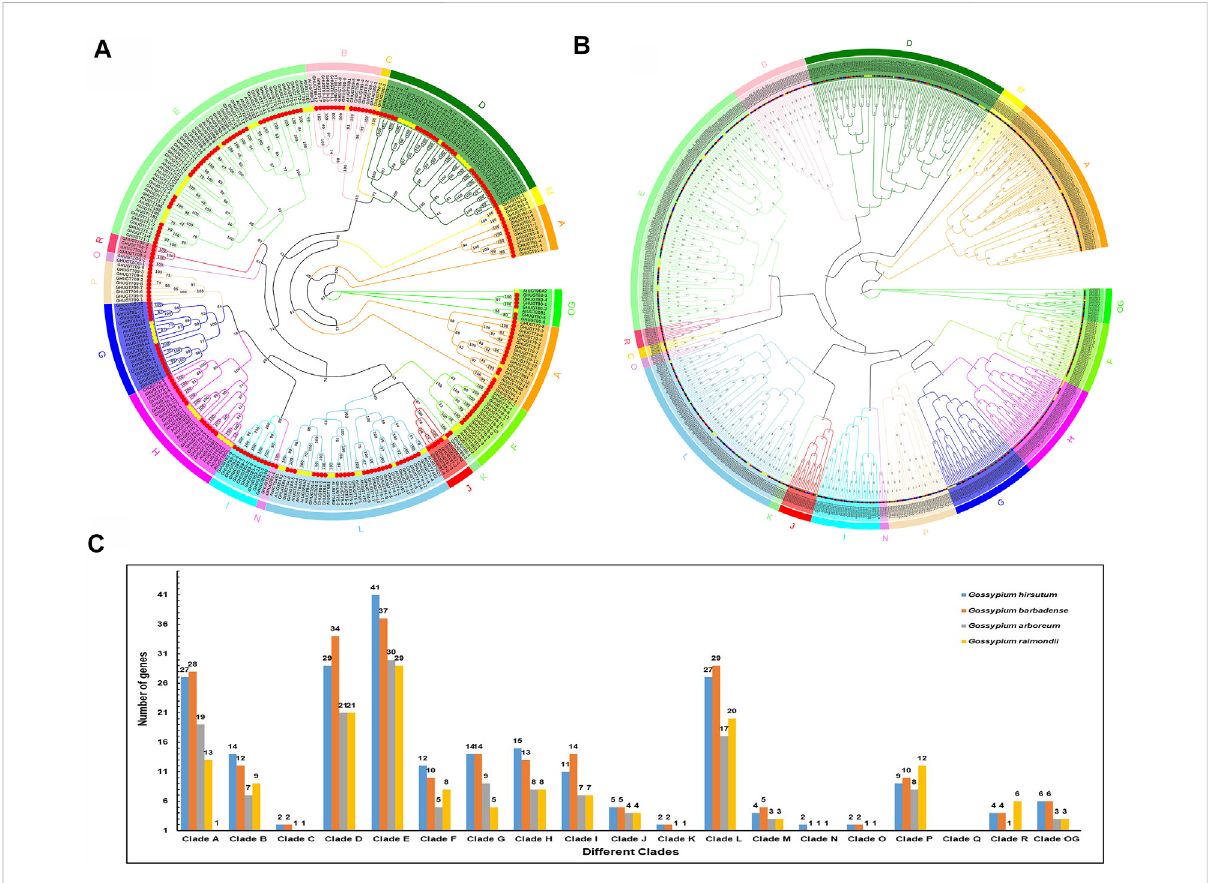
FIGURE 2 UGT gene family phylogenetic tree in fi ve plant species. (A) Phylogenetic tree of 292 UGTs from A. thaliana and G. hirsutum . (B) Phylogenetic relationship of 752 identi fi ed UGTs from four cotton species. (C) Distribution of UGT s into their different clades from fi ve plant